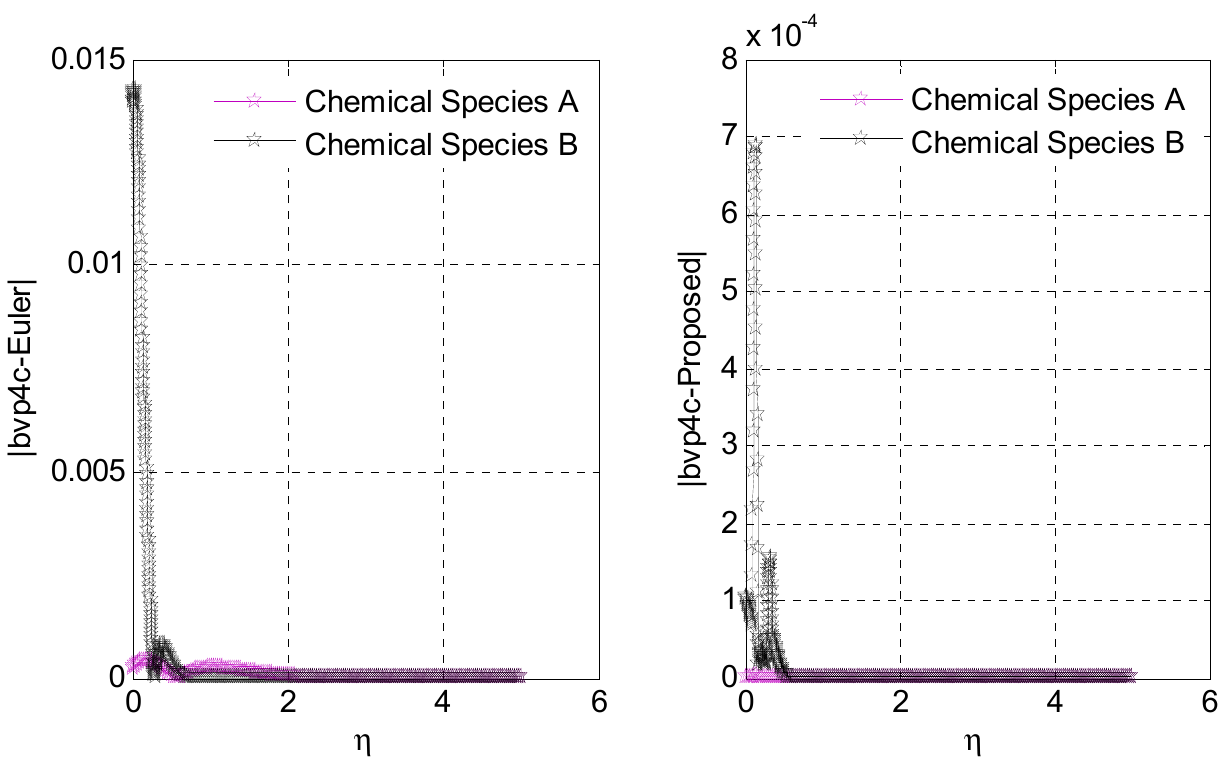
Figure 4. Comparison of the proposed scheme with the forward Euler method for species A and B using G = 1, K b = 0.1, λ = 0.1, F r = 0.1, P r = 7, R d = 0.1, Q = 0.1, Bi = 0.1, and N = 2040 .